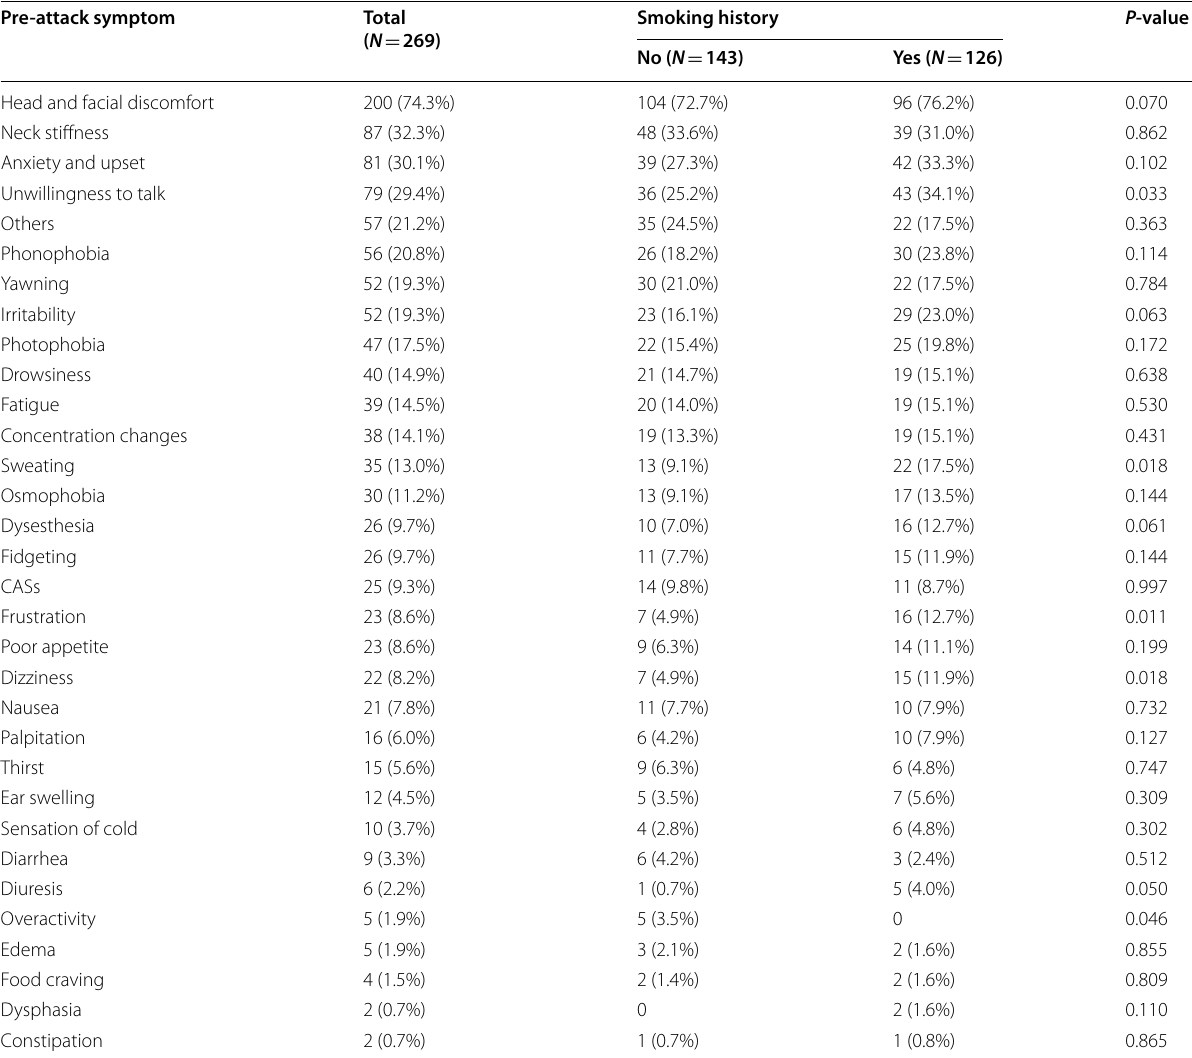
Table 3 The number and percentage of smokers/non-smokers for each type of PAS Pre-attack